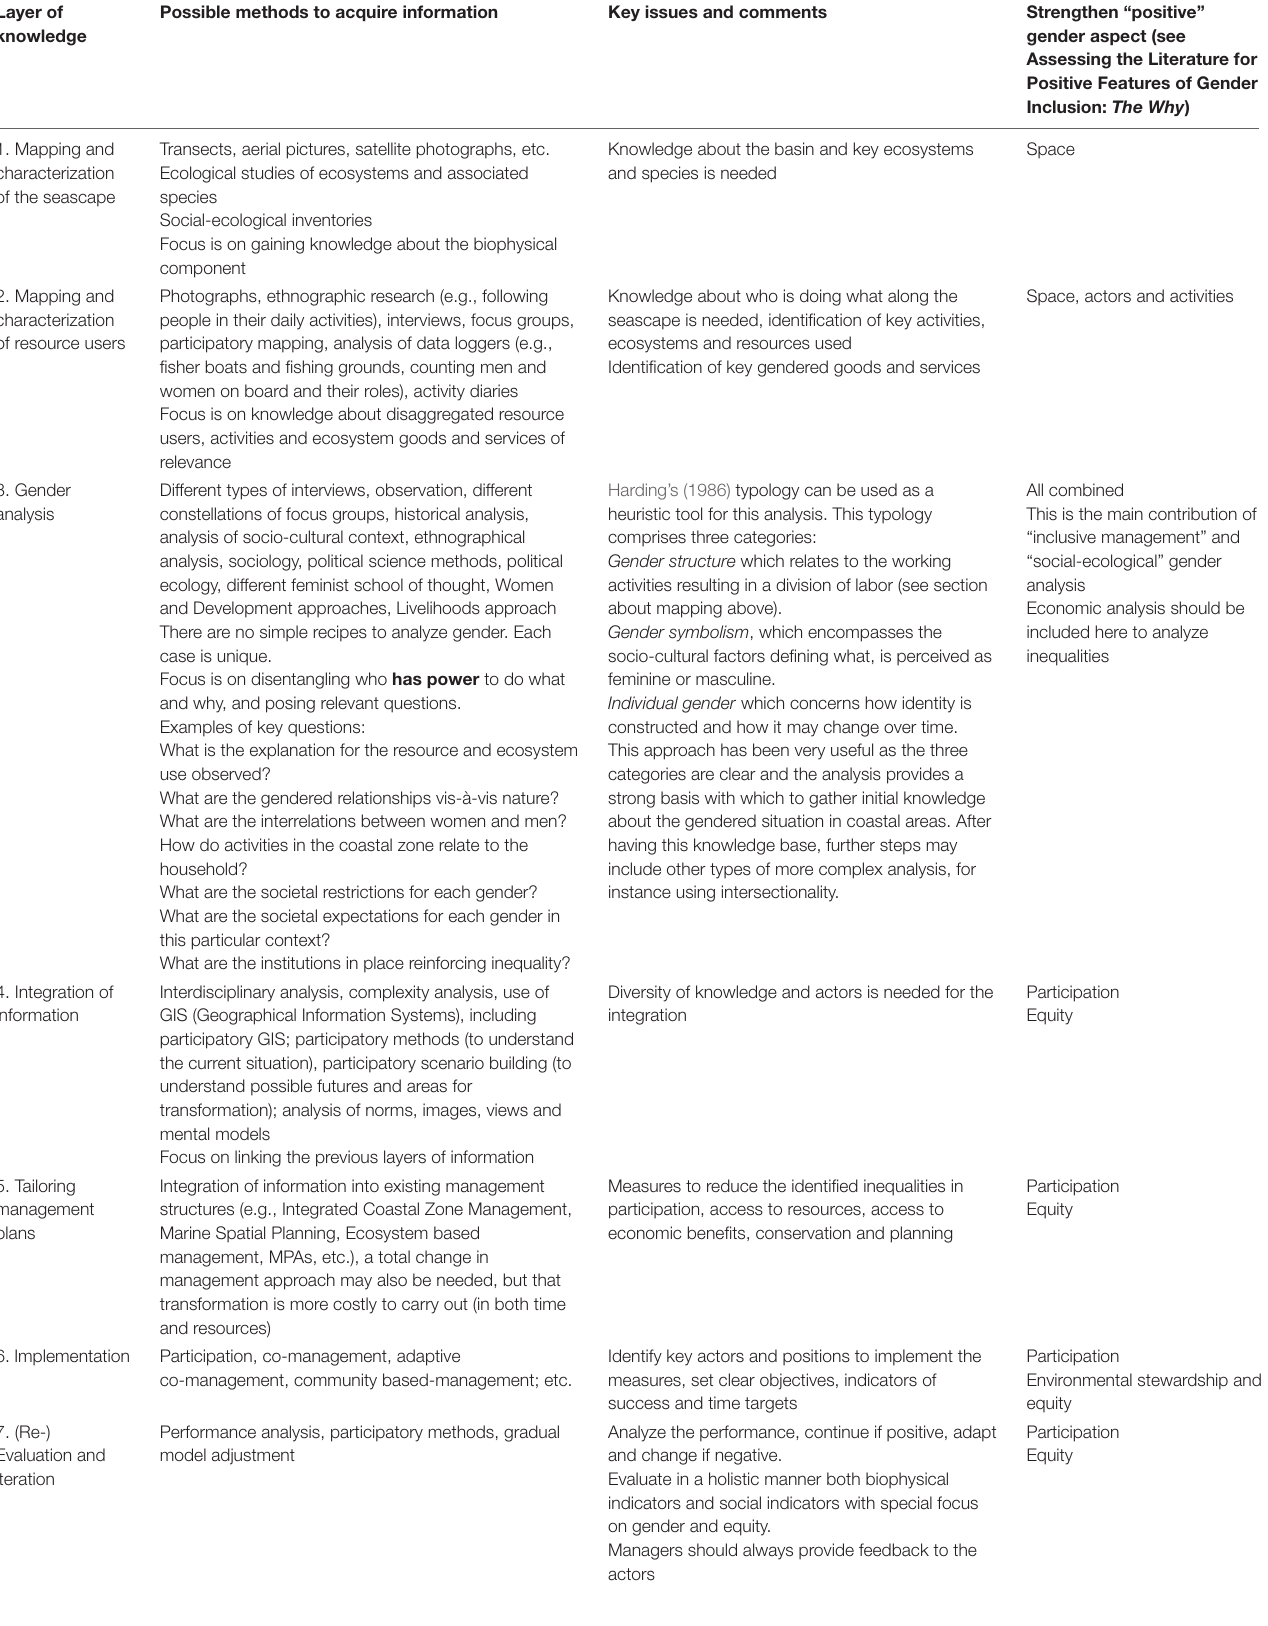
TABLE 1 | A generic social-ecological model for inclusive management through gender integration in ocean/coastal settings with associated small-scale fisheries (SSF). Layer of